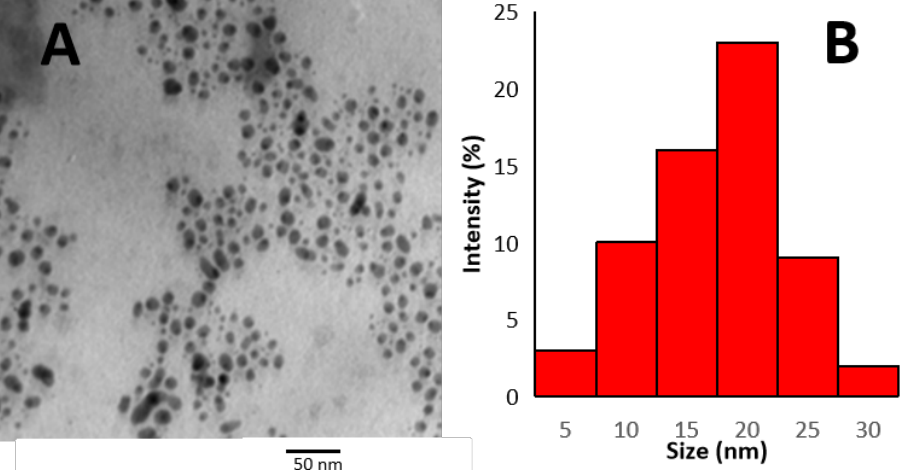
Figure 2. TEM images of the synthesized TVE-CuNPs ( A ) and percentage of the particle size distribution of TVE-CuNP ( B ).